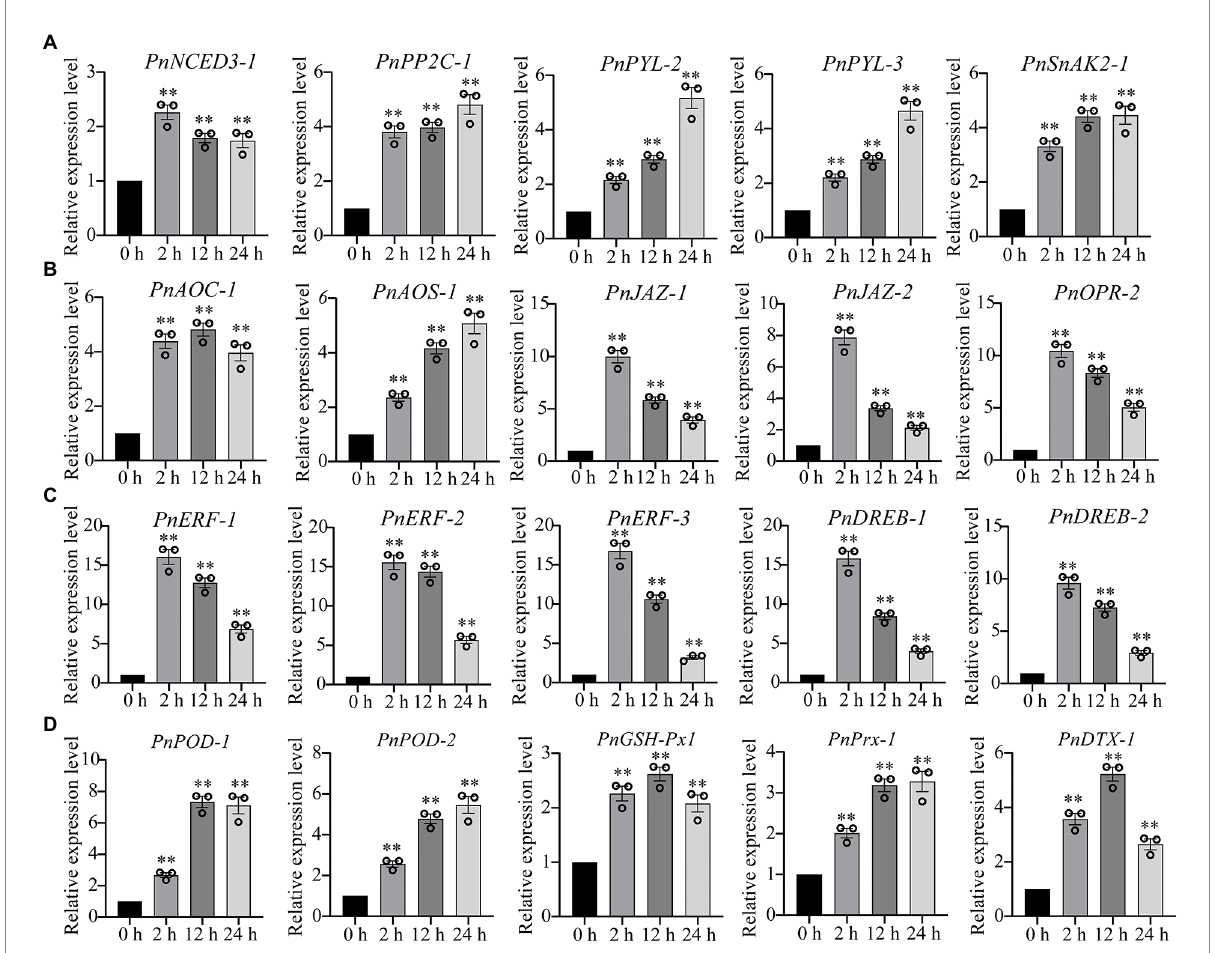
FIGURE 3 qPCR analysis confirmed the upregulation of several representative DEGs under drought stress. (A) The expression levels of genes involved in abscisic acid (ABA) signaling pathway. (B) The expression levels of genes involved in jasmonate signaling pathway. (C) The gene expression levels of ERF and DREB transcription factors. (D) The gene expression levels of antioxidant enzymes. NCED3, 9-cis-epoxycarotenoid dioxygenase; PYL, promoter-pyrabactin resistance; PP2C, type 2C protein phosphatases; SnAK2, SnRK1-activating protein kinase 2; OPR, 12-oxophytodienoate reductase; AOC, allene oxide cyclase; AOS, allene oxide synthase; JAZ, jasmonate ZIM domain protein; ERF, ethylene-responsive element binding factor; DREB, dehydration responsive element-binding transcription factor; POD, peroxidase; GSH-Px, glutathione peroxidase; Prx, peroxiredoxin; DTX, protein DETOXIFICATION. The data were calculated from three biological replicates. Vertical bars are means ±SE. Significant difference ( ** p <